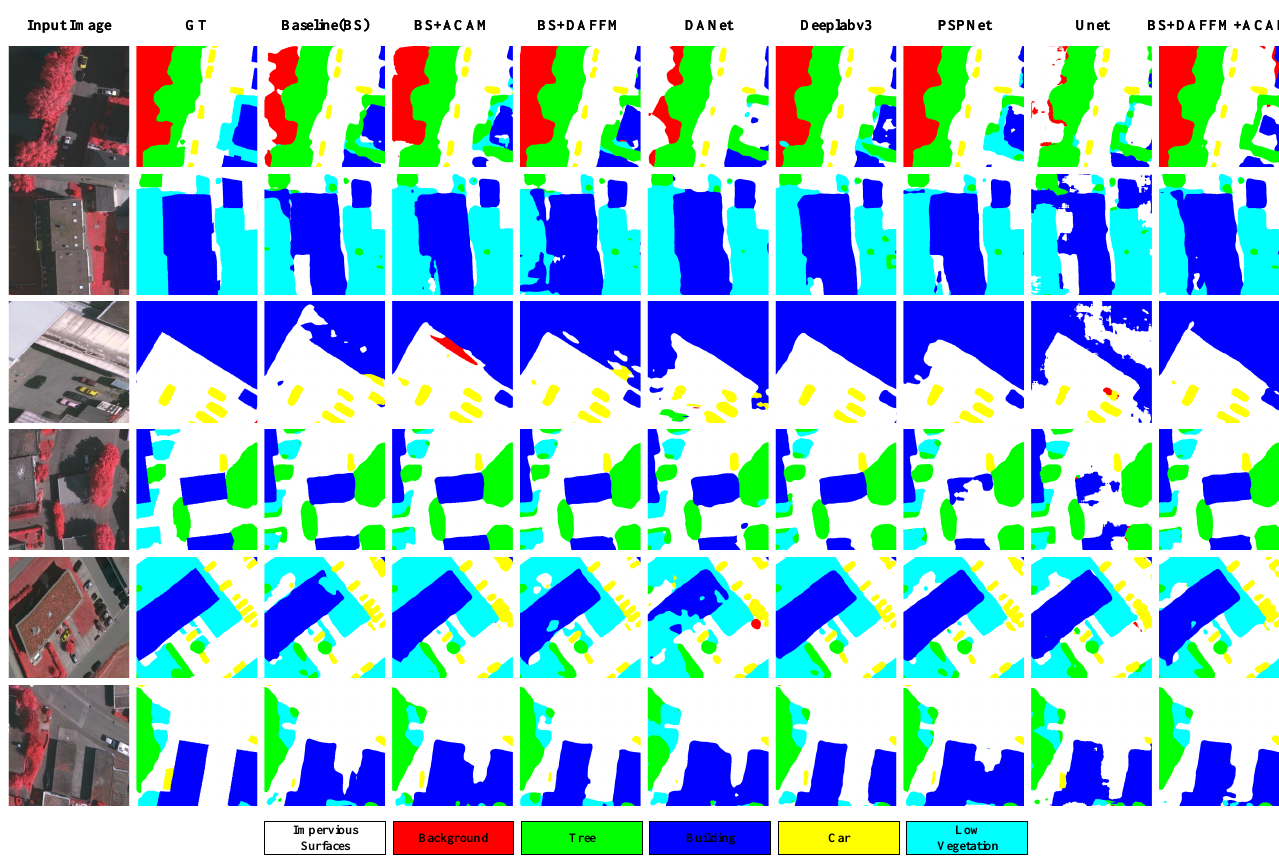
Figure 6. Visualization of the segmentation results for state-of-the-art methods based on ISPRS 2D Semantic Labeling Vaihingen data [35]. From left to right, the input image, the ground-truth segmentation results, the results from our methods and the state-of-the- art